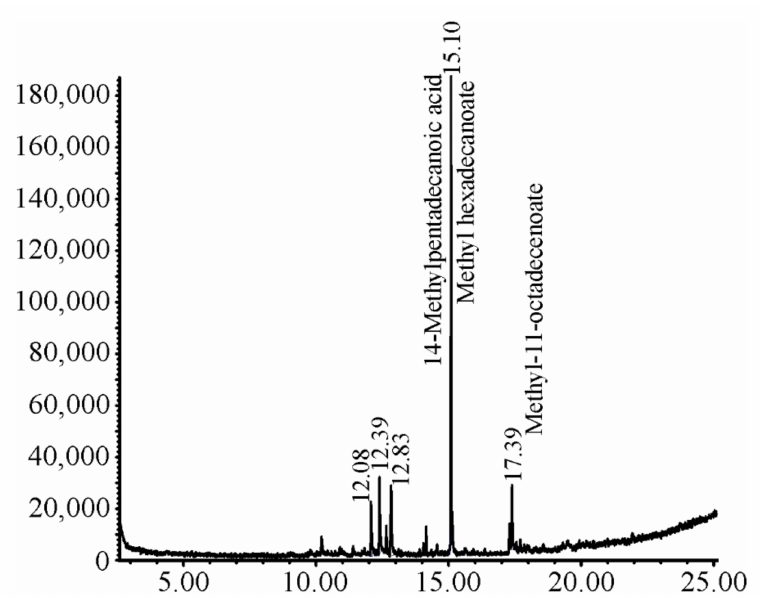
Figure 1. GC-MS chromatogram of Sf.Cr. The sample was injected at 220 ◦ C having the scanning range of 70–700 m / z and compounds were identified by comparing retention time and mass fragmentation using NIST 2014 mass spectral